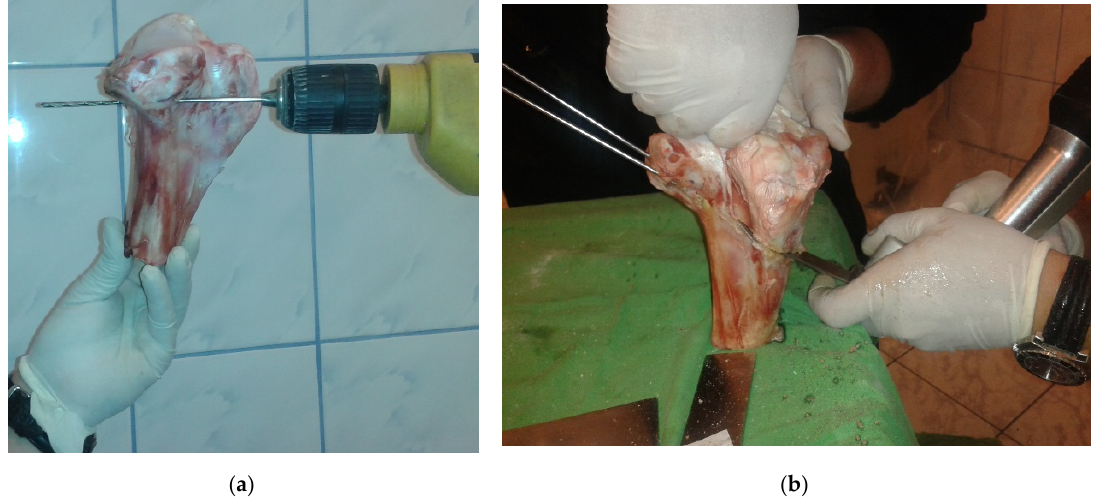
Figure 5. Execution of the hole in center of the rotation of the angulation (CORA) ( a ) and sectioning the osteotomy plane ( b ).